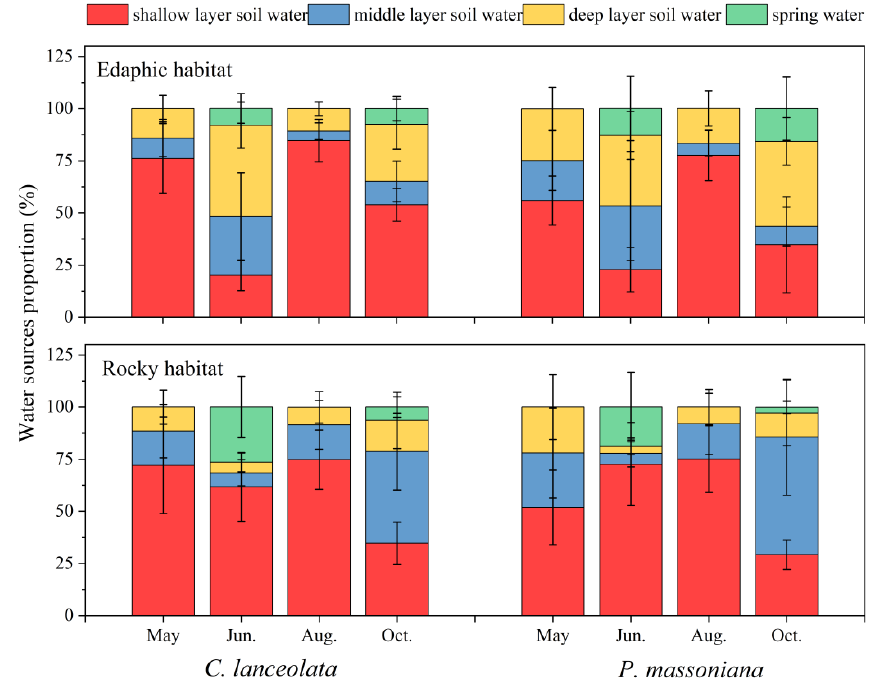
Figure 6. Variation in mean ( ± S.D.) water source proportions for C. lanceolata and P. massoniana during the wet season.